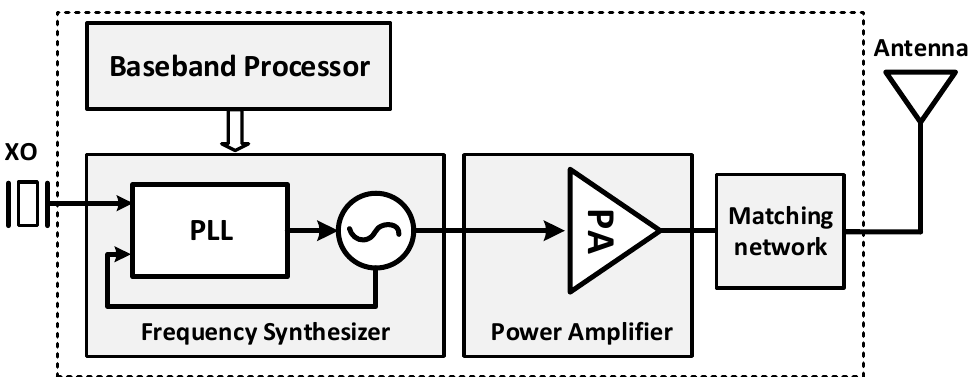
Figure 8. Conventional architecture of BLE transmitters.